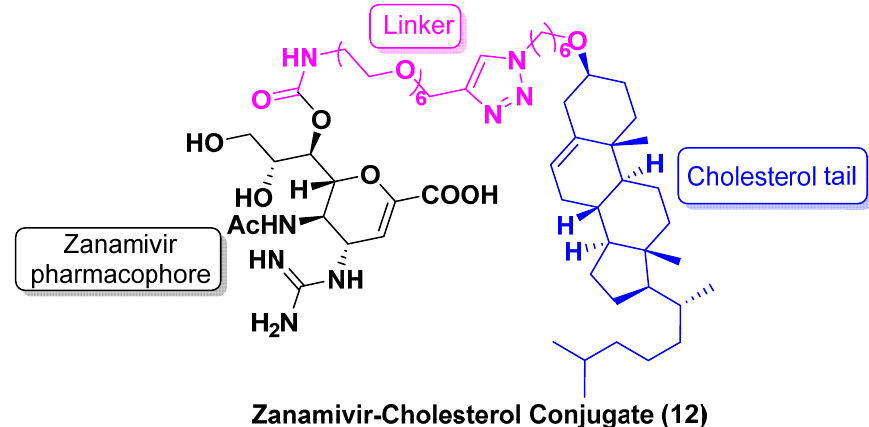
Figure 8. Chemical structure of zanamivir–cholesterol conjugate ( 12 ) [38].